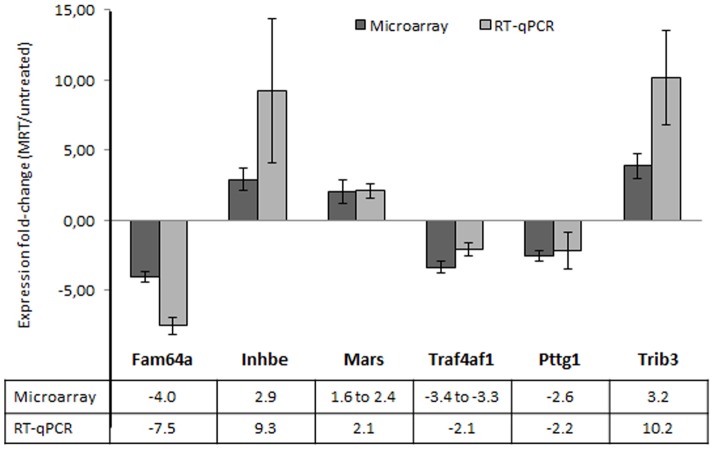
Validation of microarray analysis by quantitative RT-PCR on tumor tissue samples.Data were first normalized to the expression of Arpc1 and Atp5b housekeeping genes. The fold changes (±SEM) in each gene expression was calculated using the mean expression in treated (n = 6 for microarray and n = 8 to 9 for RT-qPCR) versus untreated (n = 5 for microarray and n = 7 to 10 for RT-qPCR) tumors 6 h after MRT. Fold changes are indicated below the histograms (several fold changes were available for microarray because of the presence of several probesets). All tested genes presented a significant difference between treated and untreated tissues (p<0.05; permutation t-test).